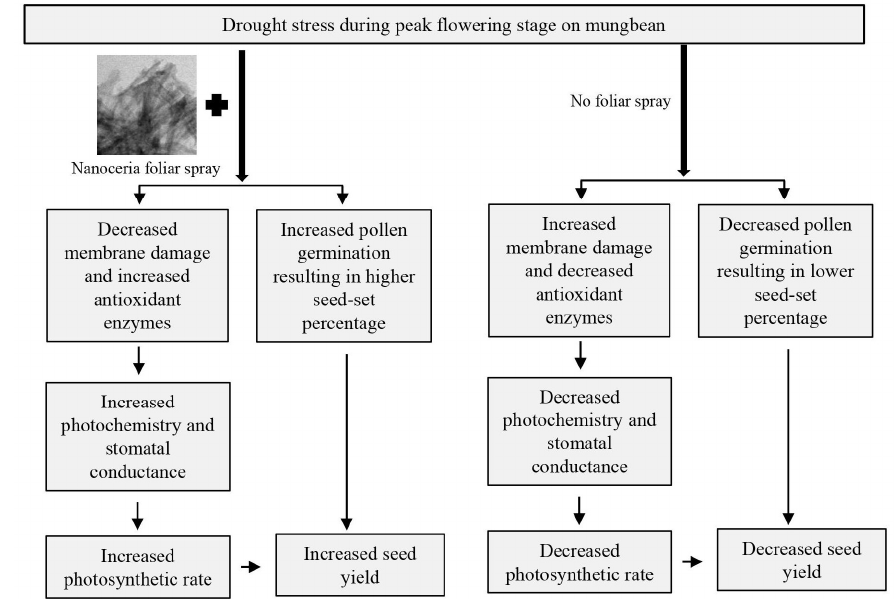
Figure 9. Proposed mechanism of action of nanoceria under drought stress in mungbean.